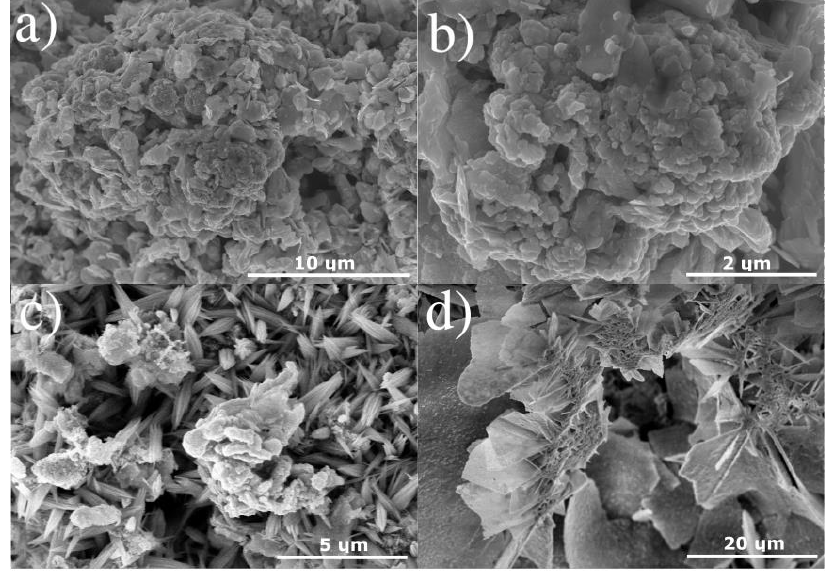
Figure 10. Composite Cu–MoS 2 -coated samples ( a ) before and ( b ) after potentiodynamic polarization in 0.1 M H 2 SO 4 , ( c ) after polarization in 0.1 M NaOH, and ( d ) after polarization in 0.1 M NaCl.